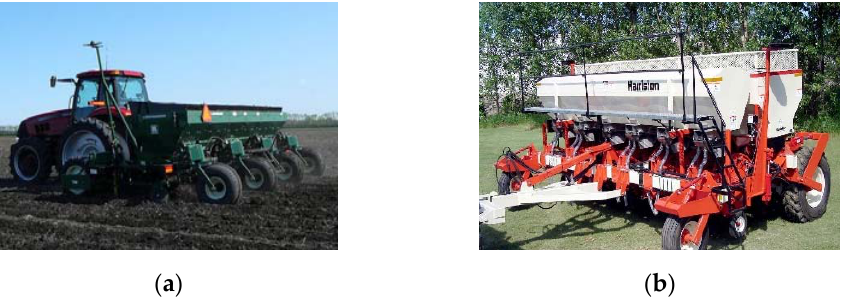
Figure 17. Needle-stabbed potato planters. ( a ) Lockwood 504. Reprinted with permission from ref. [83]. Copyright 2021 Crary Industries; ( b ) PLMS 4 rows. Reprinted with permission from ref. [96] .